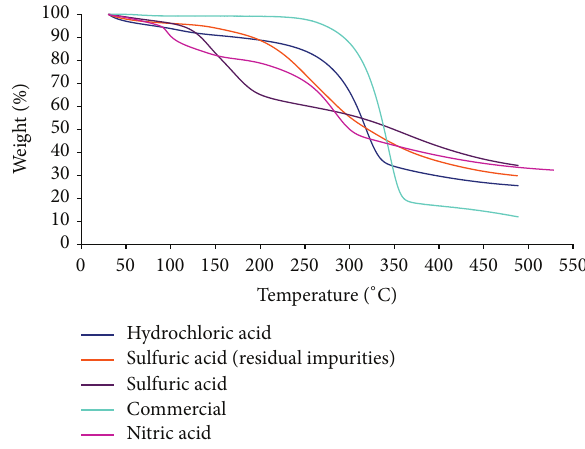
Figure 5: Revealing the thermogravimetric analysis curves for cMCC and cellulose extracted using acid hydrolysis methodology.